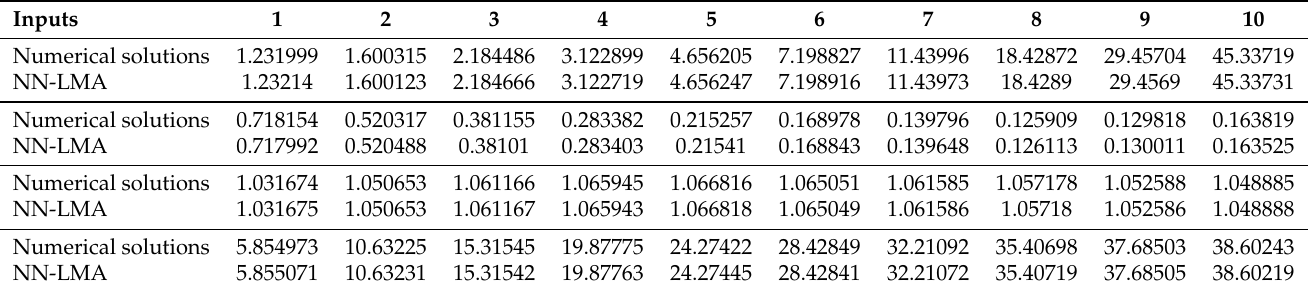
Table 6. Comparative analysis of numerical solutions by NDSolve tool in Mathematica with the solutions obtained from NN-LMA for case 1.